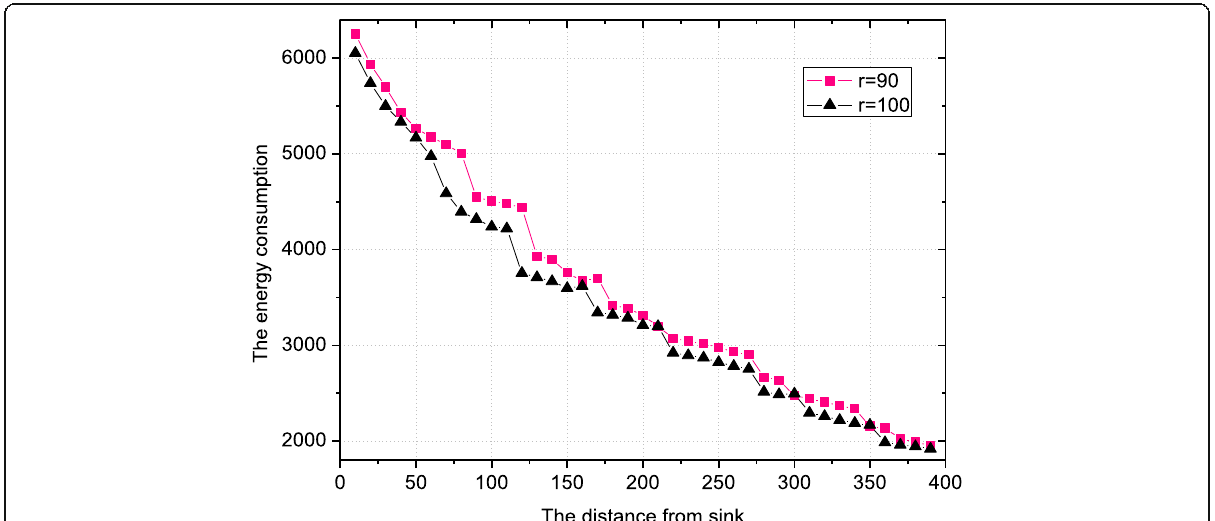
Fig. 11 The energy consumption under different duty cycle